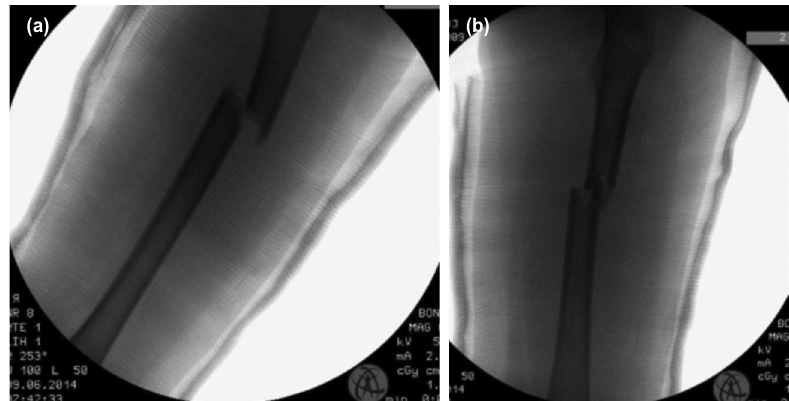
(a,b) Radiographs of the closed reduction and hip spica application of patient B. Fig. 3: